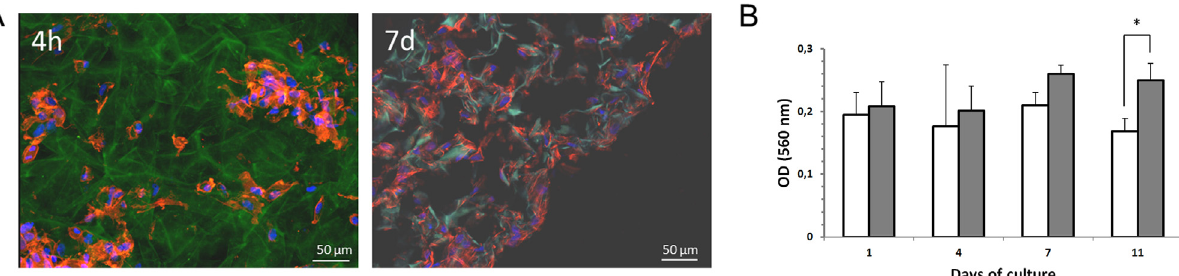
Fig 2. SDSC-seeded scaffolds. Cell matrix interactions in the scaffold (Autofluorescence/green) were evaluated 4 hours after cell seeding. Cells are presented in blue (DNA: 40,6-diamidino-2-phenylindole (DAPI)) and red (F-actin: phalloidin). After 7 days a homogeneous distribution of SDSC in the scaffold could be shown (A). Cell metabolic activity in the scaffold was evaluated for different time points by 3-(4,5-dimethyl-2-thiazolyl)-2,5-diphenyl-2H- tetrazolium bromide (MTT) assay. The metabolic activity remained significantly unchanged after 7 days of culture (white bars: LPS-stimulated SDSC; grey bars: unstimulated SDSC). 4 days later a significant difference in metabolic activity was found (B).